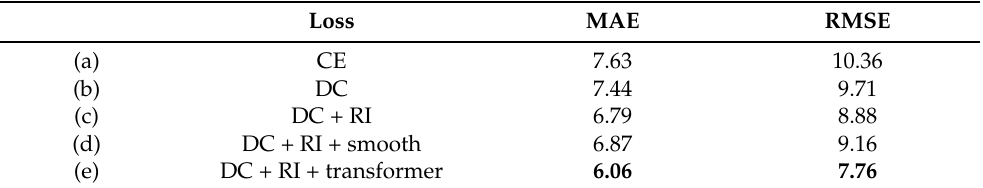
Table 3. Ablation study on different components in DR-transformer framework. In the table, DC/RI/CE represents whether to use the corresponding loss and smooth/transformer represents the way we process temporal